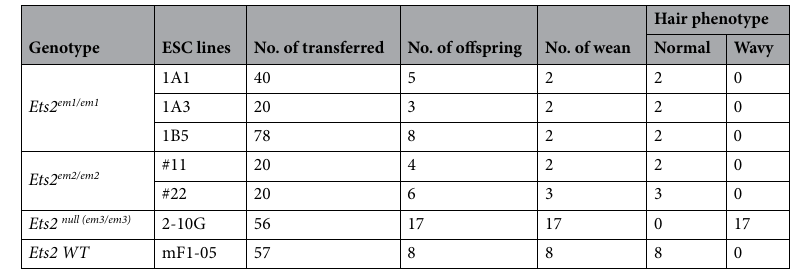
Table 4. 4n complementation of Ets2 homozygous mutant ESC lines.